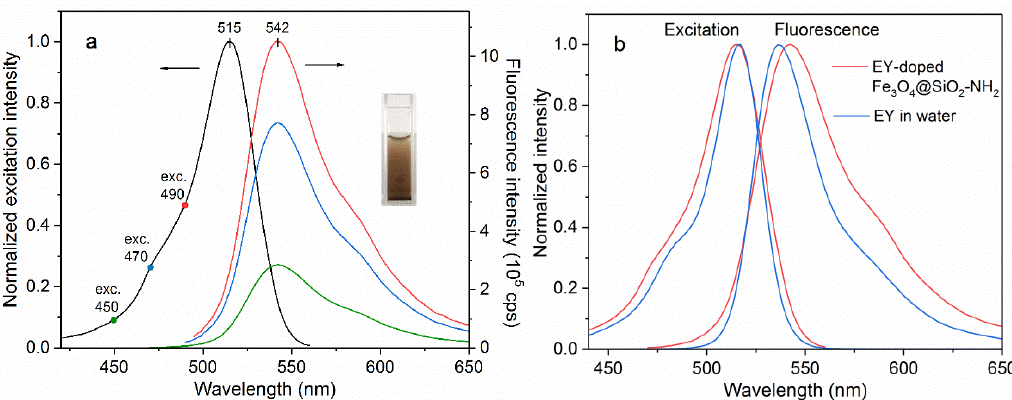
Figure 6. ( a ) Excitation spectrum and fluorescence spectrum of EY-doped Fe 3 O 4 @SiO 2 @NH 2 dispersed in water under different excitation wavelengths. ( b ) Spectral changes of EY-doped NPs in comparison with EY free in distilled water (measured pH 5.5).